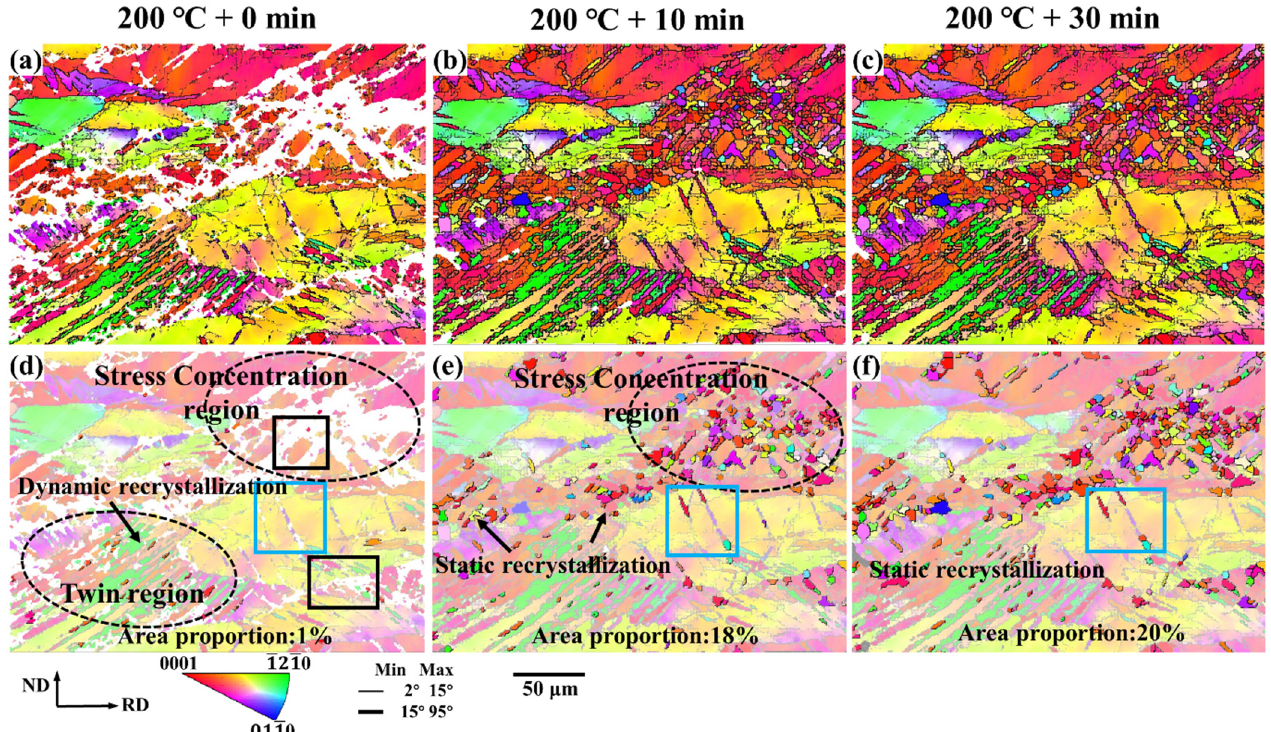
Figure 3. The microstructure evolution of the as-rolled magnesium alloy during in-situ heating: ( a – c ) IPF maps after different annealing conditions; ( d – f ) Recrystallization distribution after different annealing conditions. The resulting static recrystallization is highlighted.